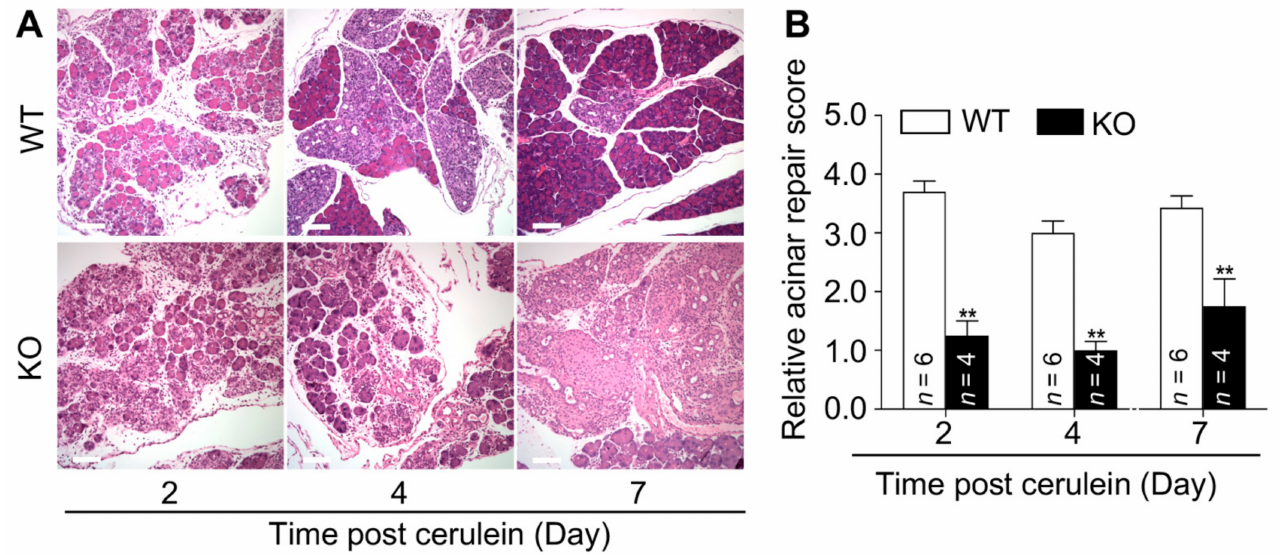
Figure 4. Mfge8 KO mice exhibit delayed recovery of pancreatic injury in cerulein-induced acute pancreatitis. WT and Mfge8 KO mice (male, 8–10 weeks old) were subjected to cerulein treatment as described in Figure 1. Animals were euthanized at indicated timepoints. ( A ) Representative histological images of pancreatic tissues (10 × , H&E stain). ( B ) Acinar cell repair was quantified in formalin-fixed pancreatic sections stained with H&E based on the scoring system in Table 2. ** p < 0.01 versus cerulein-treated WT mice. Scale bar: 100 µ